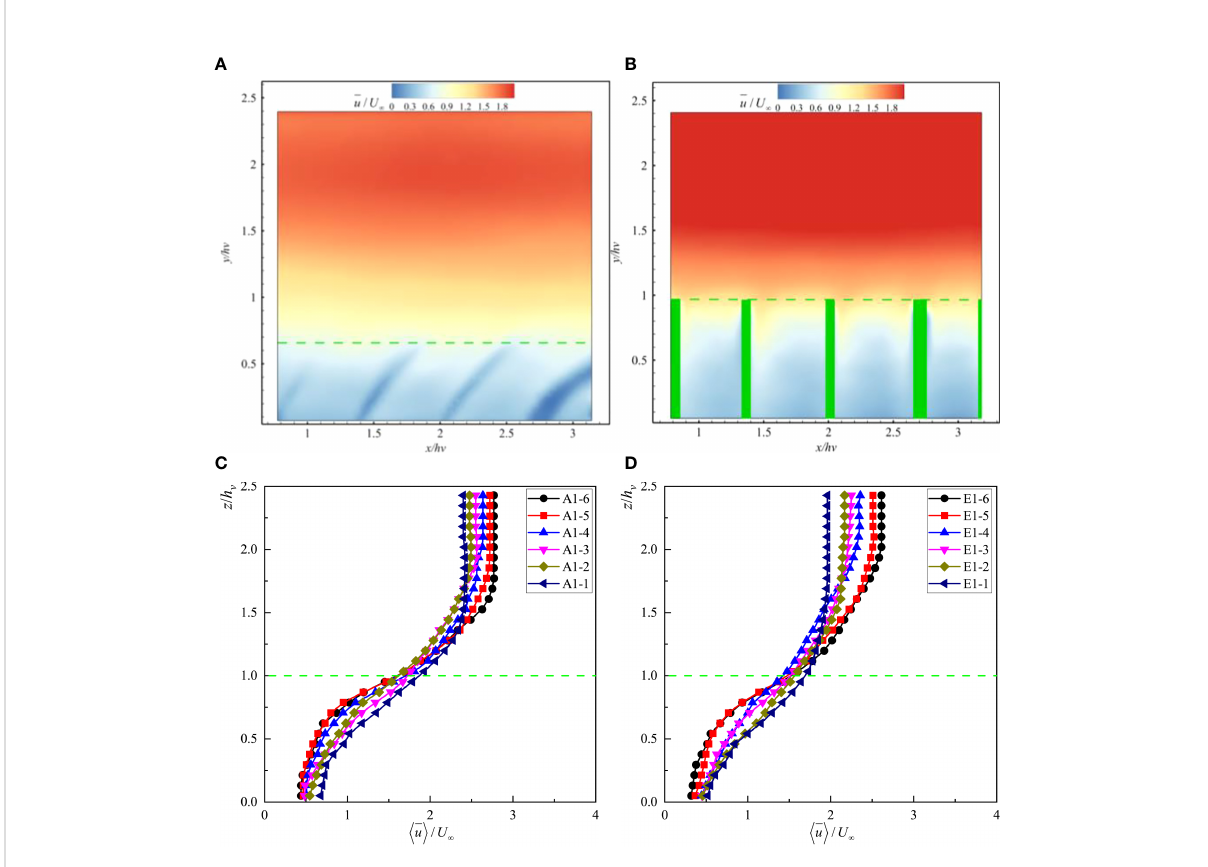
FIGURE 2 Distribution of the dimensionless time-averaged streamwise velocity 〈 (cid:1) u 〉 = U ∞ under (A) E1-1 and (B) E1-5 and the distribution of the dimensionless double averaged streamwise velocity 〈 (cid:1) u 〉 = U ∞ under (C) Test A and (D) Test